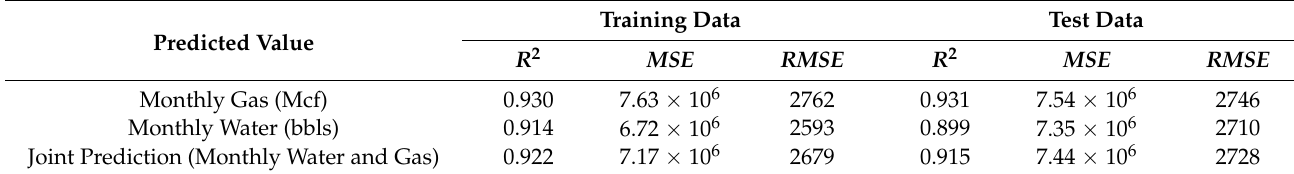
Table 5. Model results for prediction on the training and test dataset.